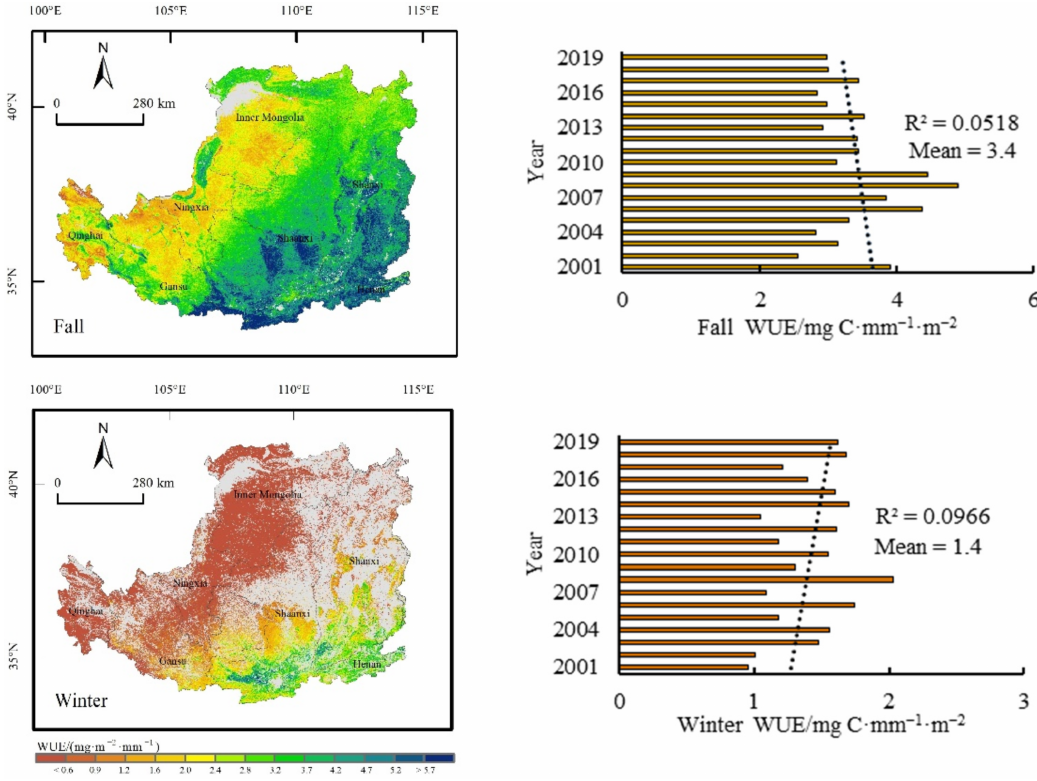
Figure 4. Spatial (left) and temporal (right) distribution of seasonal vegetation water-use efficiency (WUE) on the Loess